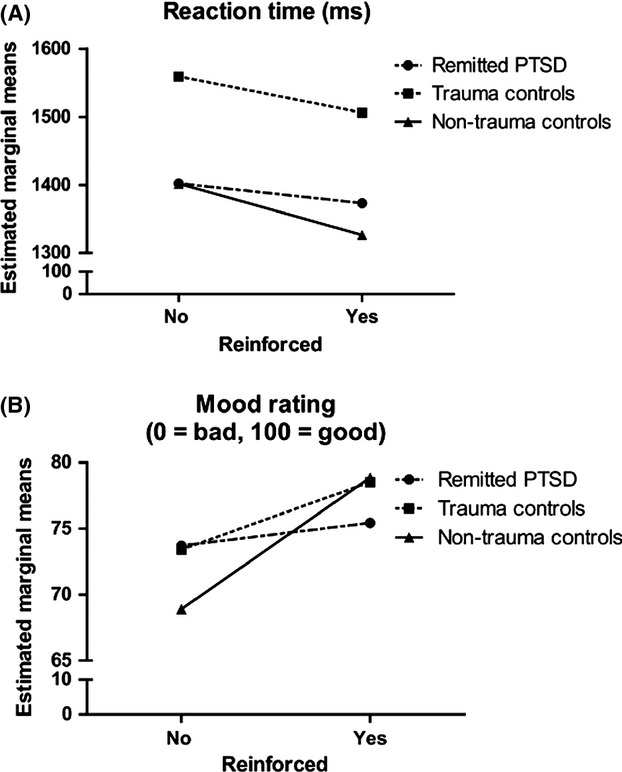
Plot of the reaction time and mood ratings across the different conditions of the task for each group of participants. (A) Reaction times: Across groups, the reaction times were slower with increasing difficulty and shorter for the reinforced condition. The nontrauma group showed the shortest reaction times and the longest reaction times were shown by the trauma controls. (B) Mood ratings: We found a significant group x reinforcement interaction (F = 3.49, P = 0.03) that is expressed by an effect of reinforcement in the trauma control (P = 0.05) and nontrauma (P < 0.001) groups but not for the remitted PTSD group (P = 0.83).